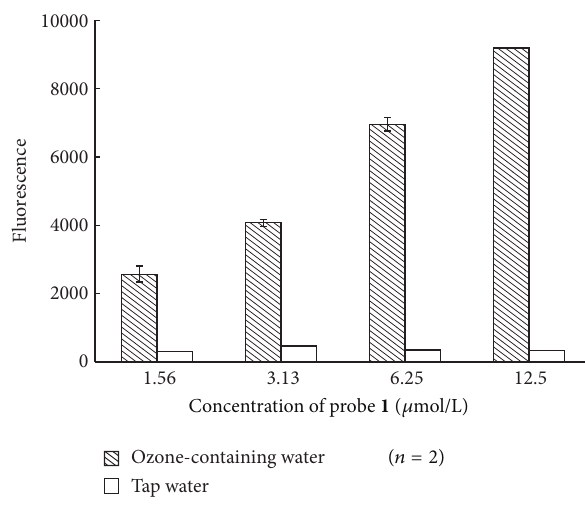
Figure 4: Effect of concentration of probe 1 on fluorescence intensity.